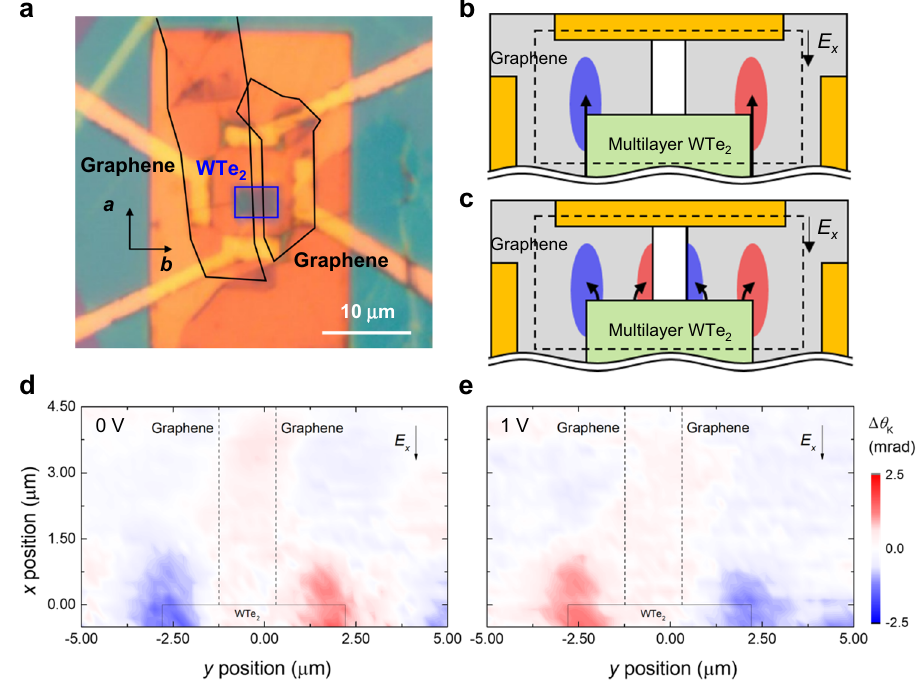
Fig. 4 | Spatially resolved differential Kerr rotation on a device with a spatial gap in graphene. a An optical microscopy image is shown. Two monolayer gra- phene fl akes are separated by a 1.5 μ m gap. This device scheme is almost identical totheotherdevices,exceptthepresenceof agapingraphene.Thegraphenelayer for the electron transport measurement is located below WTe 2 . b , c Schematic diagrams of the expected Δ θ K when the spin-polarized electrons are injected in graphene from the hinges ( b ) and when they originate from the bulk ( c ). Dashed rectangles indicate the window of spatially resolved measurement, and black